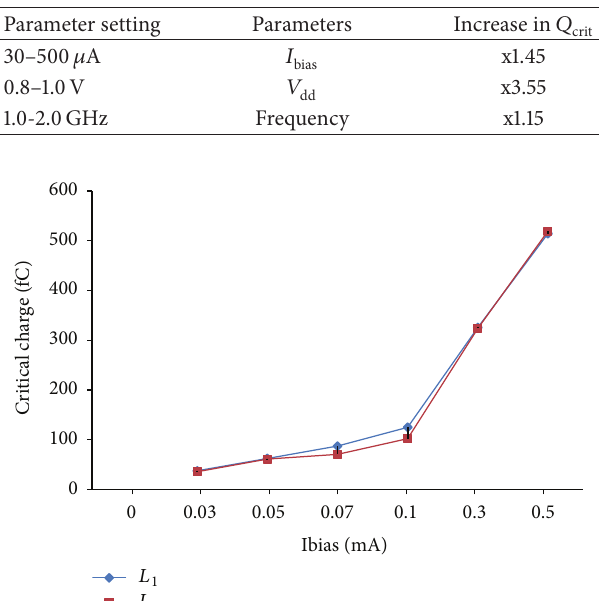
Table 1: Qualitative comparison of 𝑉 quency against 𝑄